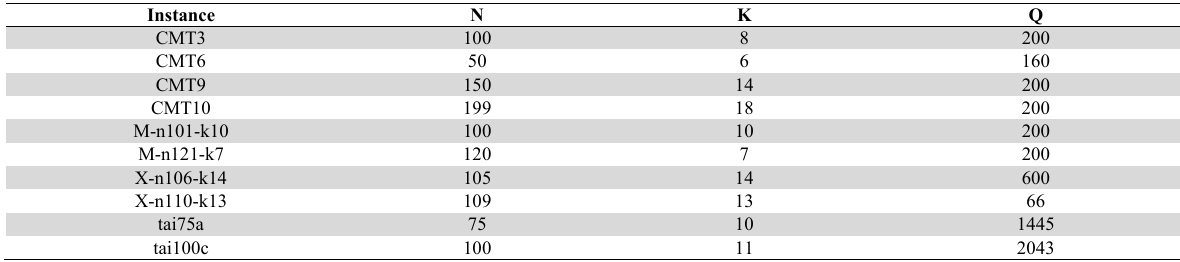
Characteristic of Instances